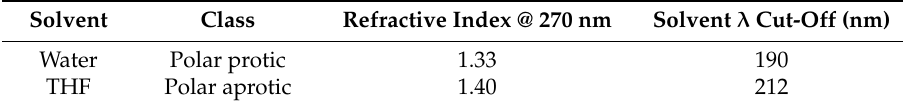
Table 1. Solvent properties. Optical characteristics were extracted from [27].